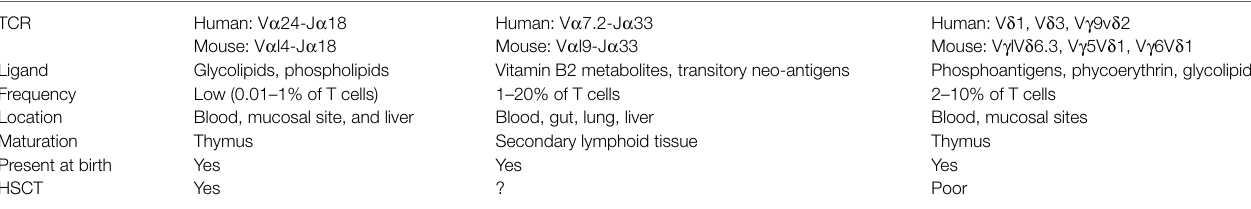
TABLE 1 | Characteristics of innate T cells